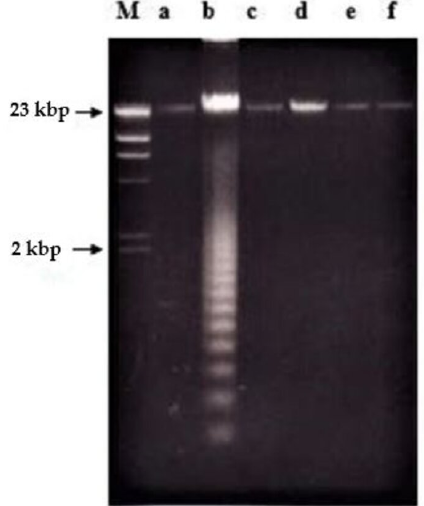
Figure 9. The involvement of Ca 2+ /Mg 2+ -dependent endonuclease and protein synthesis in damnacanthal-induced apoptosis in CEM-SS cells at 24 h. Zinc sulphate and cycloheximide prevented apoptosis induced by 30 μg/mL of damnacanthal at 24 h. Lane a: control. Lane b: damnacanthal (30 μg/mL). Lane c: zinc sulphate (0.1 mM). Lane d: damnacanthal (30 μg/mL) + zinc sulphate (0.1 mM). Lane e: cycloheximide (10 μg/mL). Lane f: damnacanthal (30 μg/mL) + cycloheximide (10 μg/mL). Lane M: Marker (HindIII digest of lambda DNA).